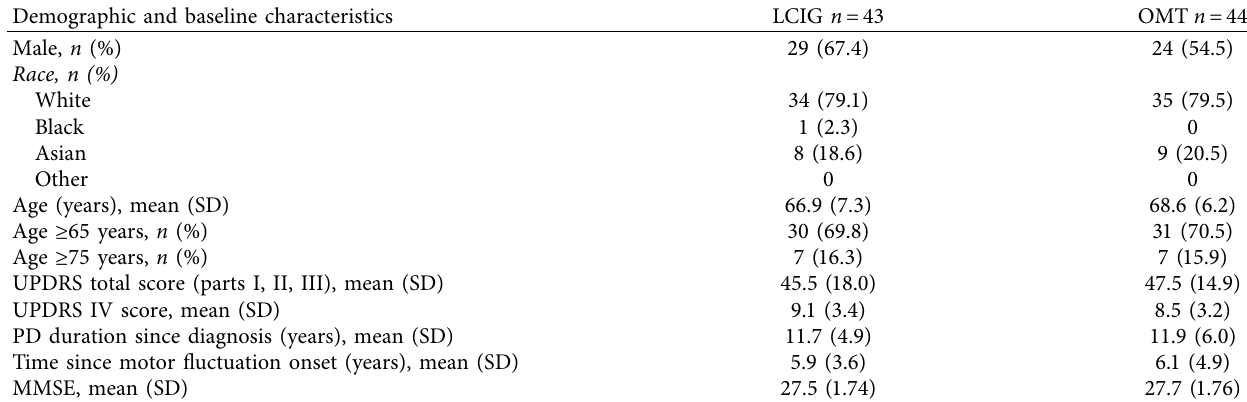
Table 1: Baseline demographics and disease characteristics in the safety population.